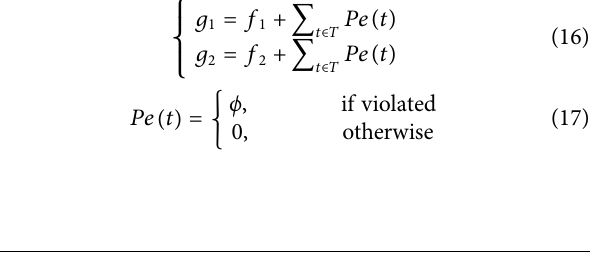
TABLE 2 | Speci fi c parameter settings of PV